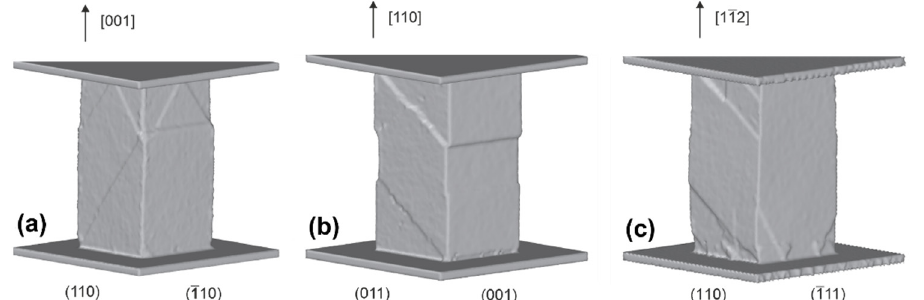
Figure 3. The deformation relief of simulated single crystals in the case of free lateral faces, ε = 7% (panels ( a – c ) differ in the direction of the deformation axis and the orientation of the lateral faces, which are indicated in the sub ‐ pictures).